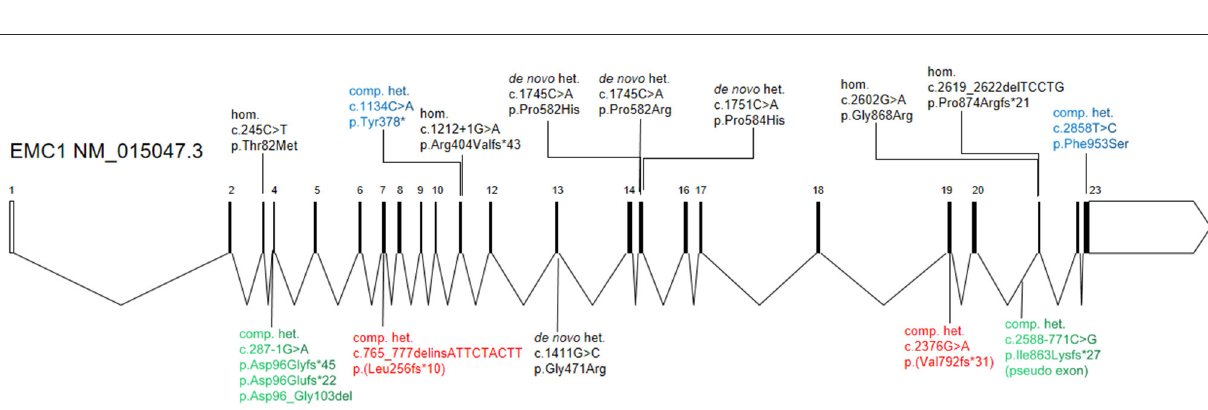
FIGURE2 Schematic diagram of the EMC1 gene structure and variations associated with global developmental delay. The compound heterozygous variants from current study (red color) and two previous studies (green and blue colors) are highlighted. The previously reported homozygous or heterozygous variants are shown in